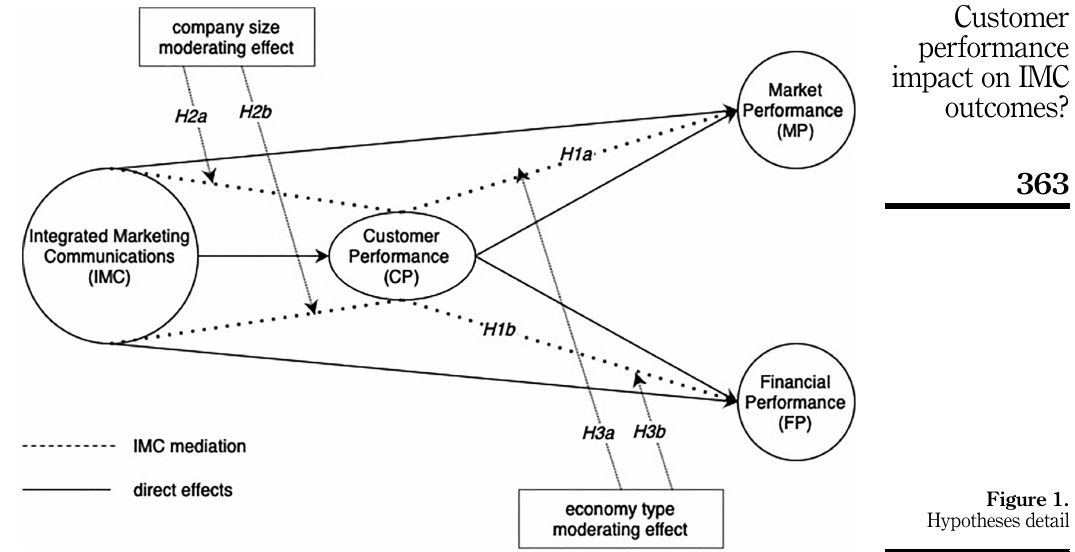
Figure 1. Hypotheses